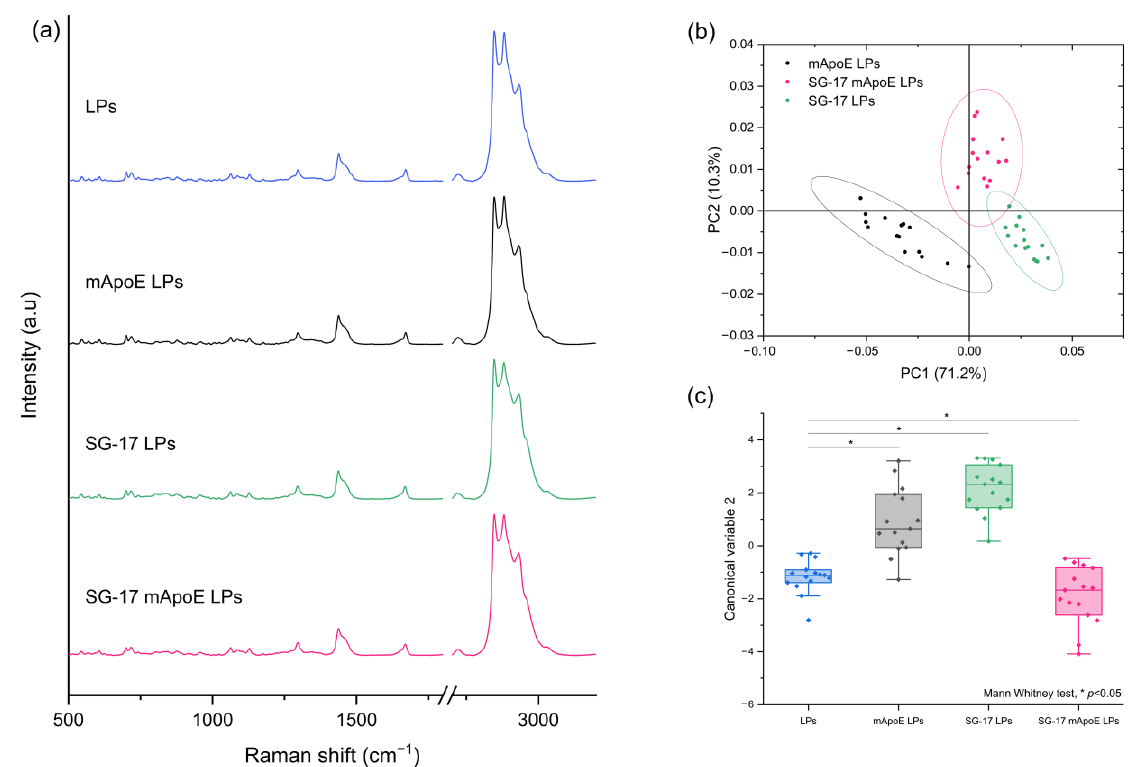
Figure 4. ( a ) Raman spectra of LPs with different surface functionalization: non-functionalized LPs (LPs, blue), LPs functionalized with mApoE (mApoE LPs, black), LPs functionalized with SG-17 (SG-17 LPs, green), LPs functionalized with SG-17 and mApoE (SG-17 mApoE LPs, pink); ( b ) graph- ical representation of PC1 and PC2 extracted from PCA on mApoE LP, SG-17 LP and SG-17 mapoE LP spectra. The ellipses represent the 95% confidence interval; each dot represents one spectrum; ( c ) statistical analysis (FMann – Whitney test) on Canonical Variable 2 derived from Linear Discrimi- nant analysis for the four formulations.